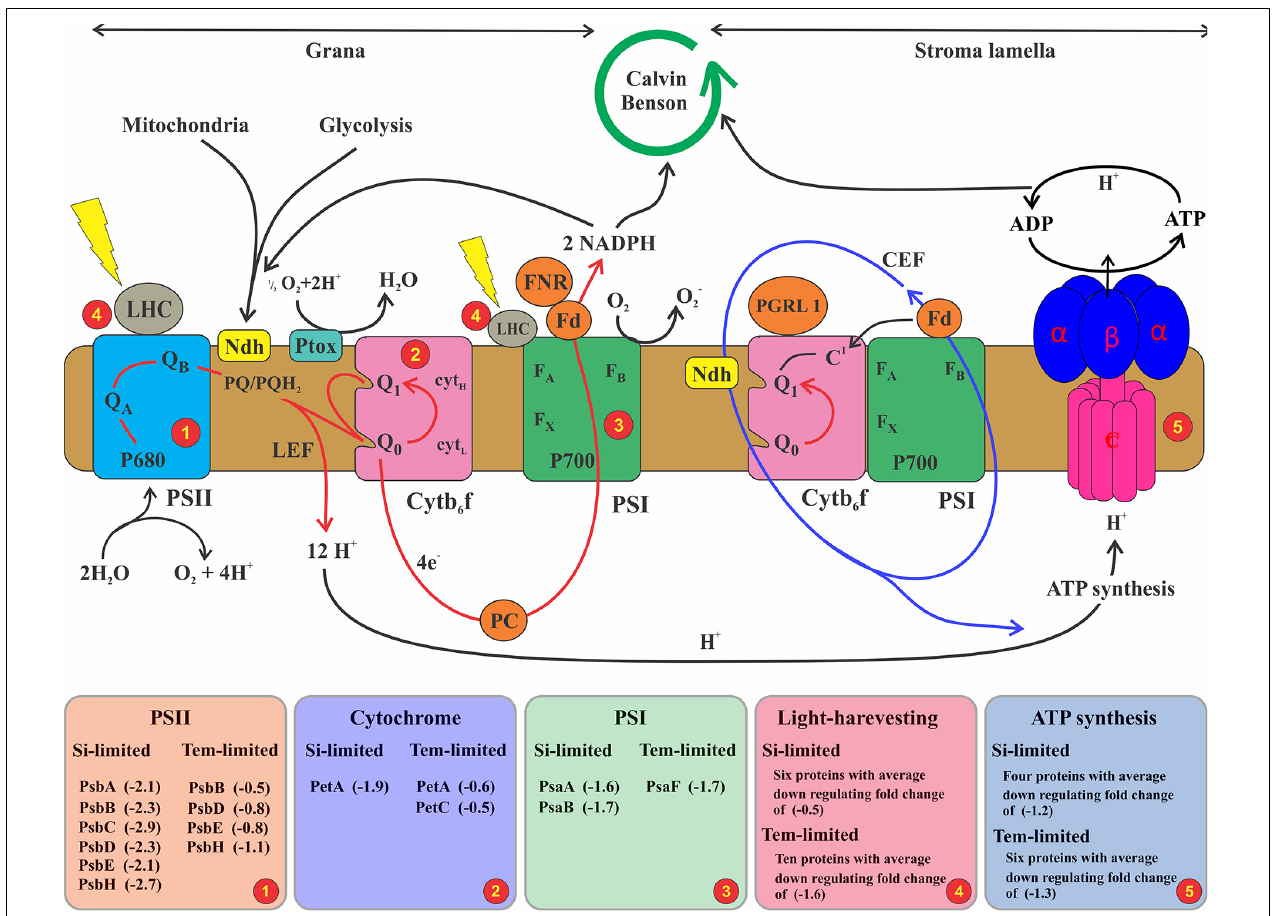
FIGURE 6 | Schematic illustrating the photosynthetic electron transport chain and state transition model. The depicted model consisting of linear and cyclic electron flow and ATP generation. Linear electron flow (red arrow) associated with photosystem II (PSII), cytochrome b6f (Cytb6f), photosystem I (PSI), and ferredoxin-NADPH (FNR). PSII is composed of activation of oxidoreductase transferring an electron from water to plastoquinone, resulting in the reduced form of PQH 2 . In this process, when adequate linear electron transfer occurs, it is catalyzed by FNR to NADPH on one side, and simultaneously, proton gradient drives the ATP synthase (ATPase). Cycling electron transport (CEF) (blue lines) is represented by a single pathway involving ferredoxin-PQ reductase, which transfers electrons from Fd to PQ. Further, under aerobic conditions, the plastoquinone terminal (PTOX) could oxidize the PQ pool; therefore, electrons, e.g., from glycolysis, are imported into the chloroplast and lead to a reduction in the PQ pool by an NADH dehydrogenase (Ndh). In this study, the net production of electron conversation by PSII was decreased over a twofold change because of downregulated PSII primary proteins that catalyze this process (see Supplementary Table 3 ). Subsequently, less electron and proton were pumped to the PSI to NADPH and ATP synthase for the Calvin cycle and carbon fixation process. Higher downregulation in LHC 1 by lower temperature (see Supplementary Table 3 ) affects the CEF electron, which has been sent to ATP synthase with less ATP formation for other cellular processes depending on these